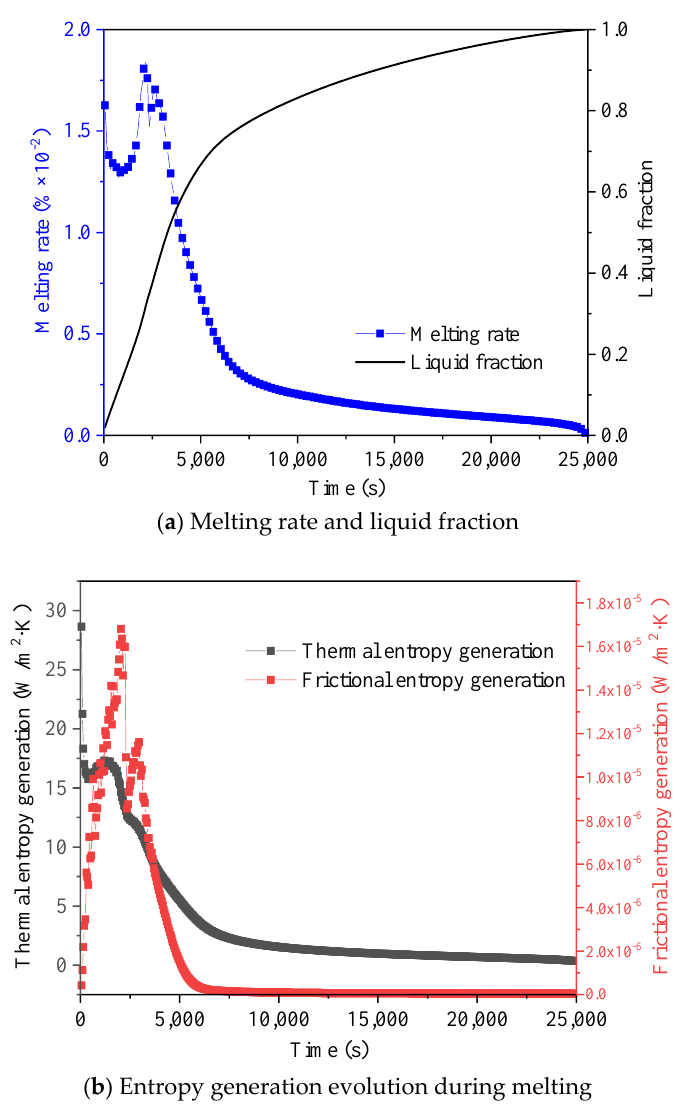
Figure 4. Temperature distribution, liquid – solid interface (left side) and local entropy generation (right side) for no-fin case in melting.